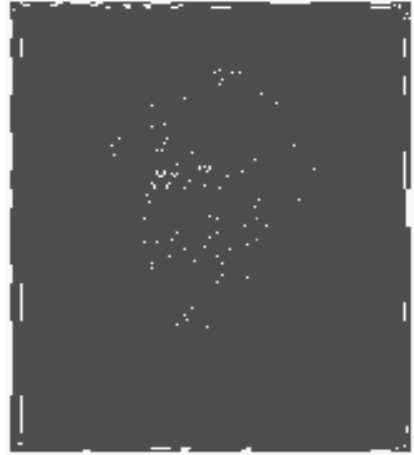
Figure 30. Archimedes using GMM.